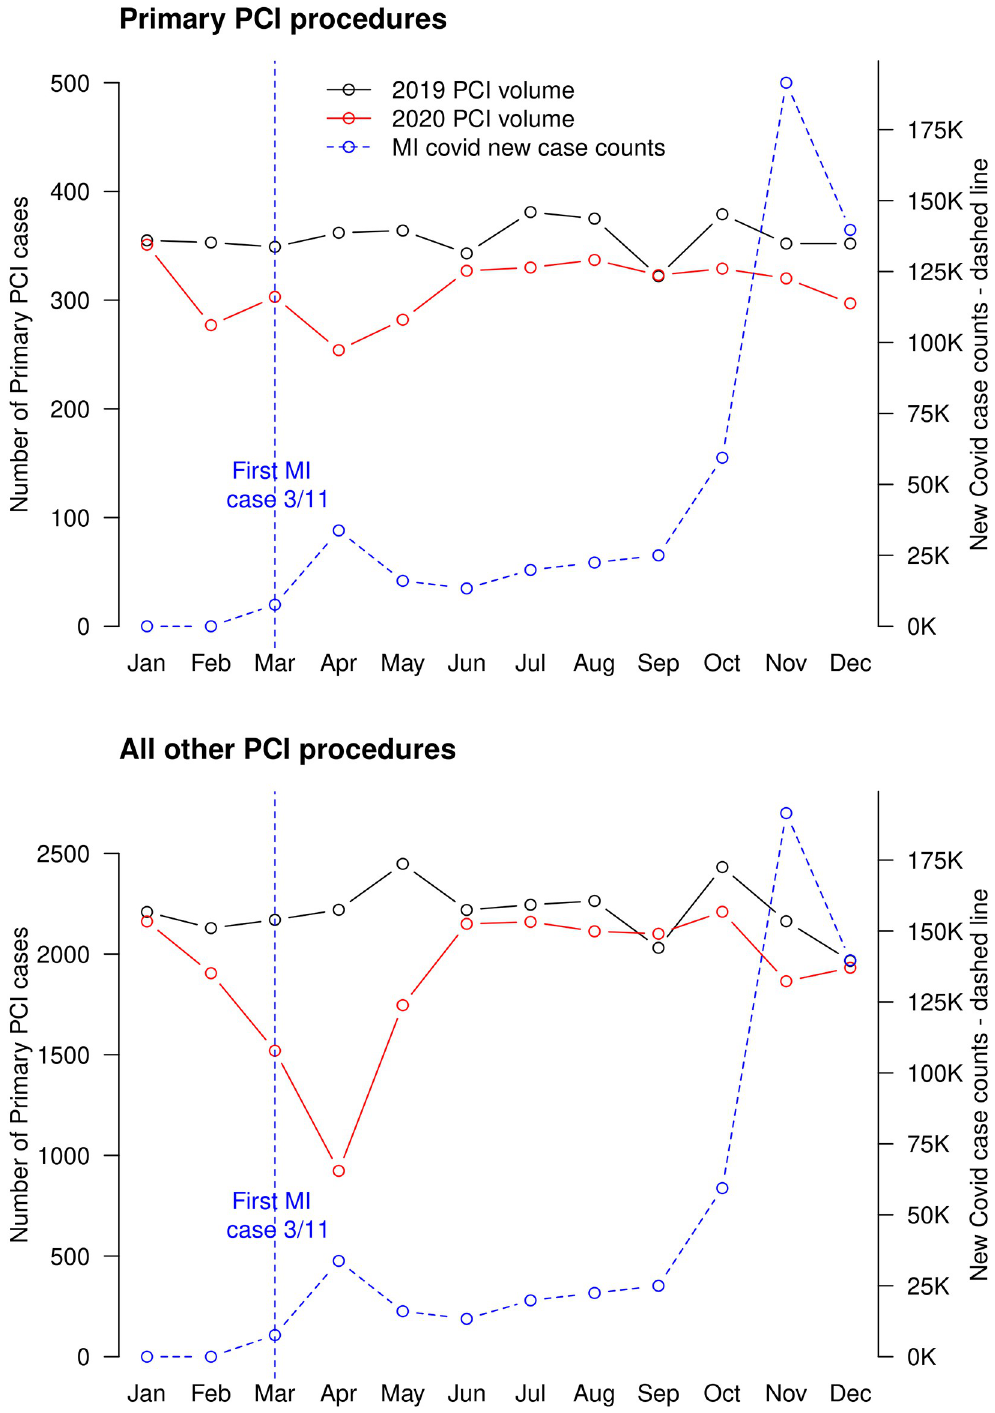
Fig 2. Monthly primary and non-primary PCI volume in the pre-pandemic (black) vs. pandemic (red) period. Monthly COVID-19 case counts (blue) are also displayed. The first COVID-19 case in Michigan was diagnosed on March 11, 2020.